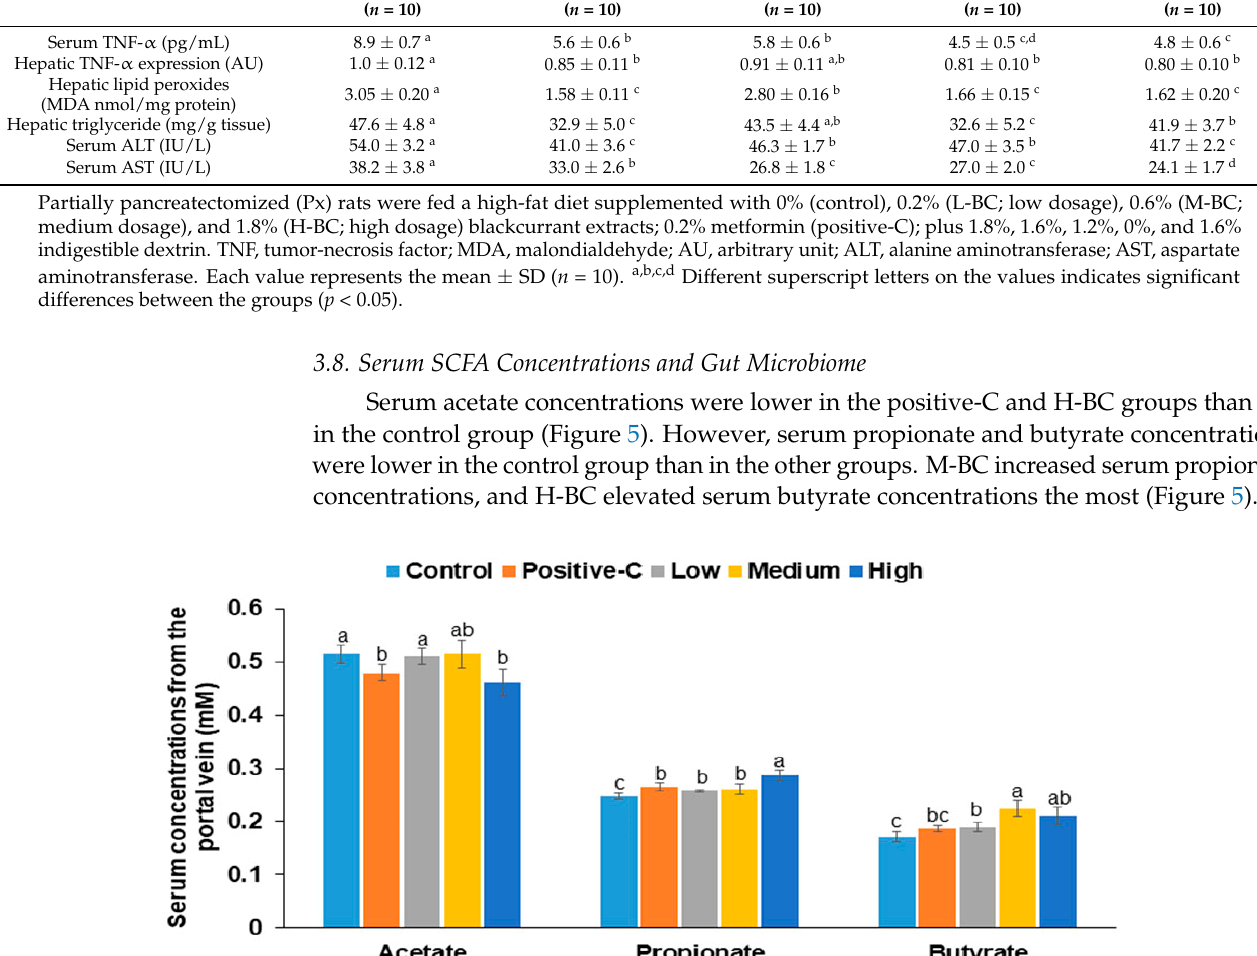
Table 4. Triglyceride contents, inflammation, and oxidative stress indexes in the liver.